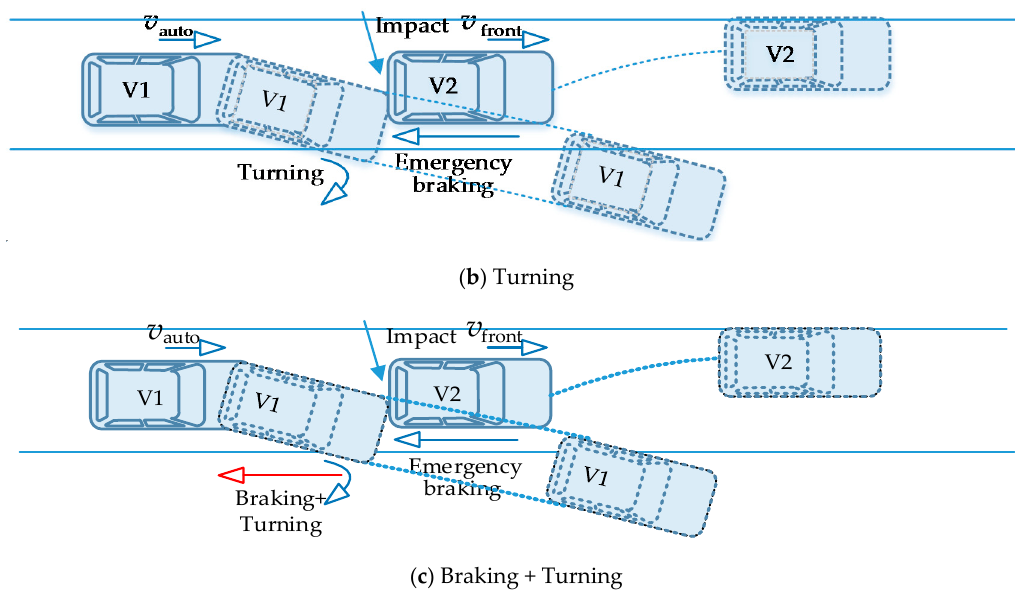
Figure 2. The crash scenarios of three emergency decisions under the emergency situation ( v auto refers to the speed of autonomous vehicle before making emergency decisions; v front refers to the speed of the front vehicle; V1 is the autonomous vehicle, and V2 is the emergency braking vehicle).